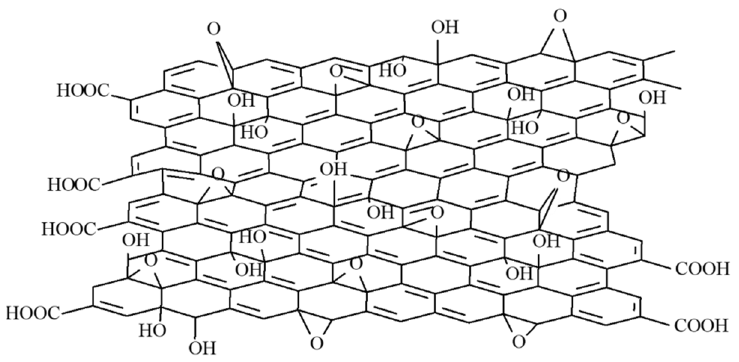
Figure 3. The structure of GO.